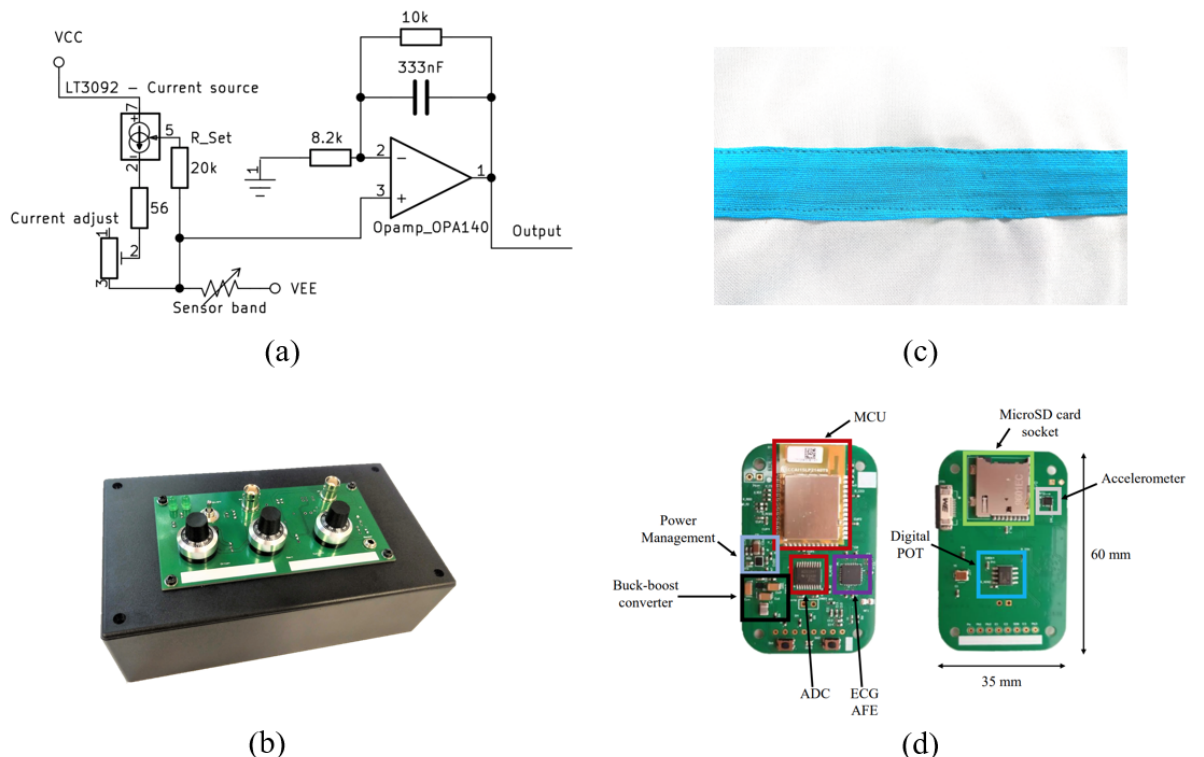
Figure 3. ( a ) Sensor instrumentation schematic view, ( b ) the developed PCB for bench tests, ( c ) the fabric sensor bands enclosed to kinesiology tape and sewn into the t-shirt fabric, and ( d ) proposed wearable data acquisition